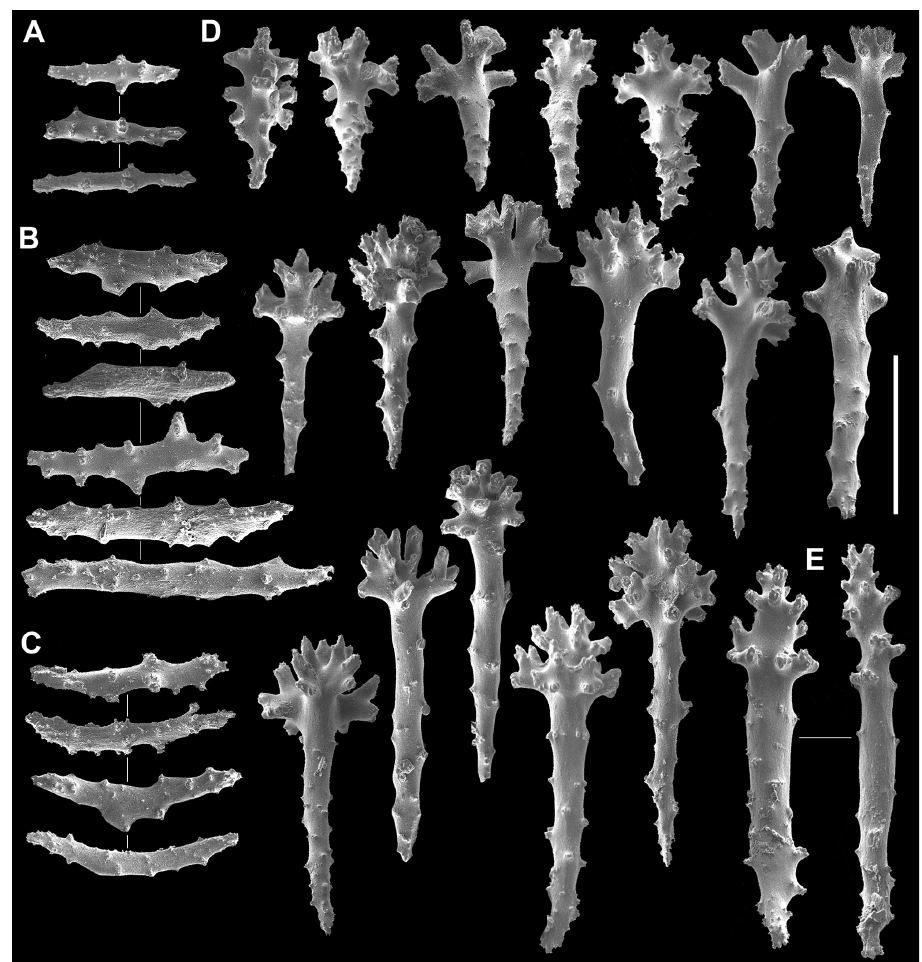
Figure 2. Sinularia mesophotica sp. n., holotype ZMTAU Co 37425. Sclerites from the polypary. A tentacle rods B straight collaret spindles C bent collaret spindles D clubs E larger clubs. Scale bar: 0.10